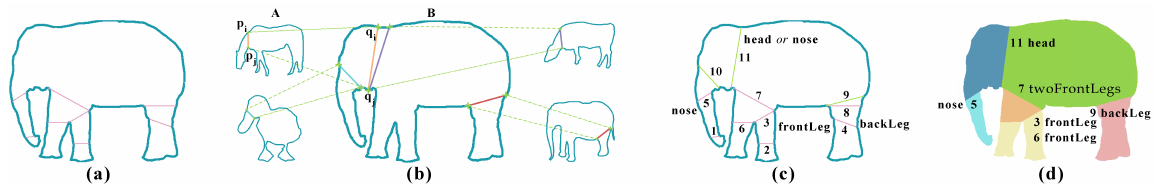
Figure 5: Semantic segmentation of an elephant. Given an unsegmented shape, cuts are computed from the geometry (a), as well as transferred from similar shapes (b). This yields multiple class hypotheses (c) which are prunen, yielding a correct semantic segmentation and annotation of the shape